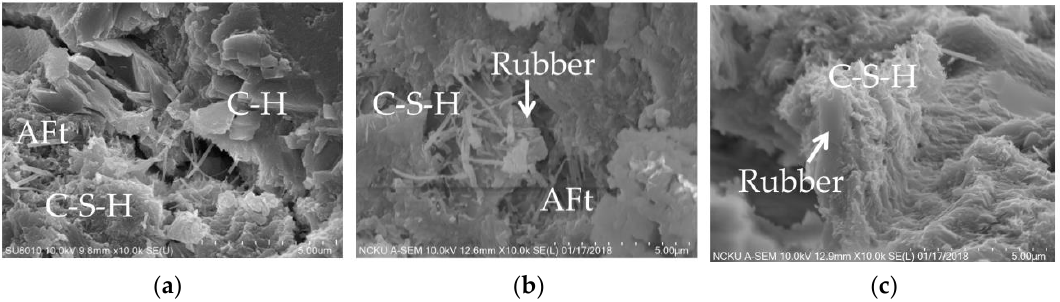
Figure 11. SEM images of cement pastes: ( a ) C0, ( b ) UR5, and ( c ) TR5.